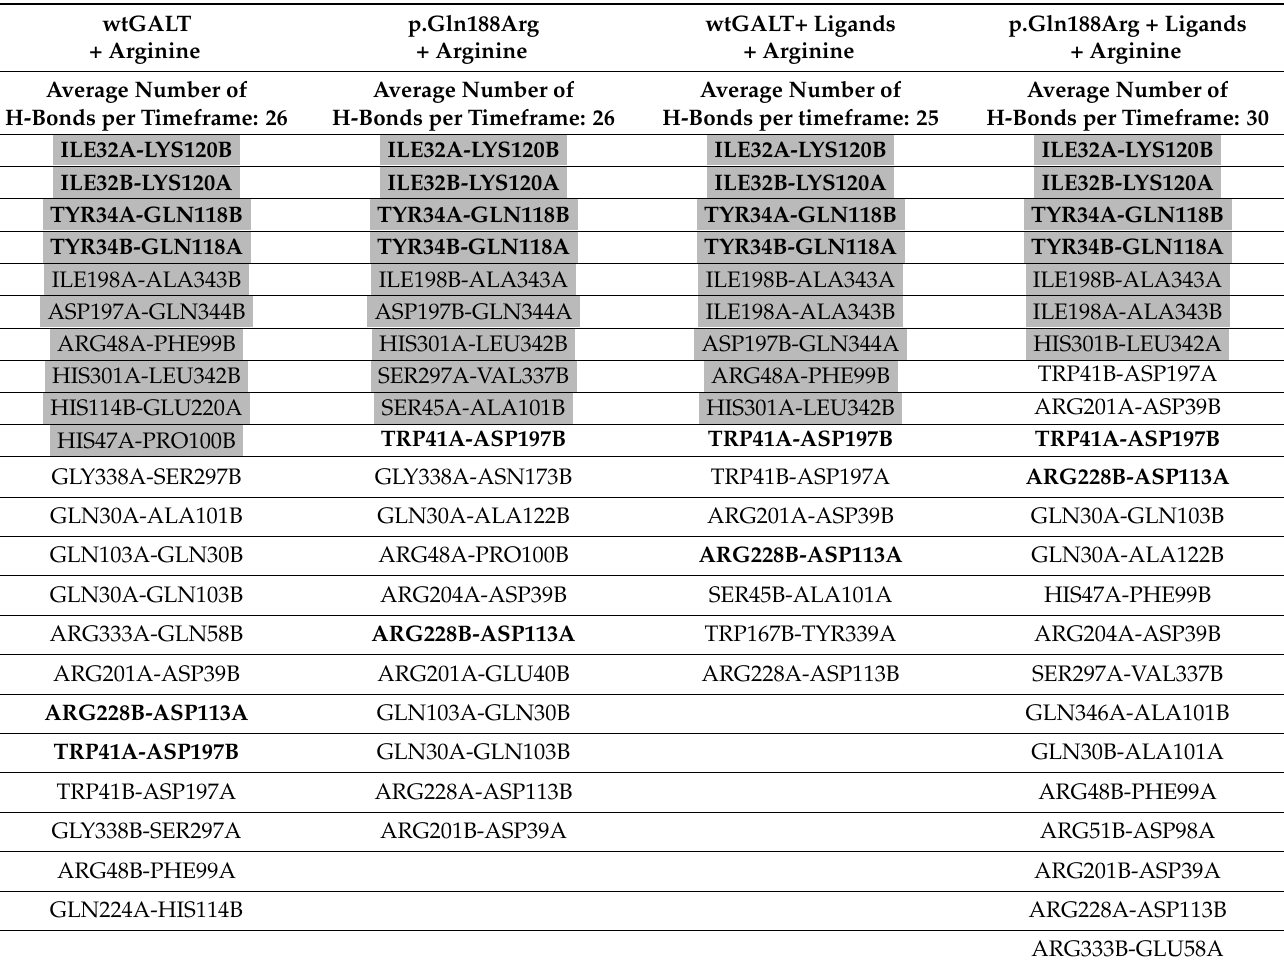
Table 4. Couples of residues involved in stable intersubunit H-bonds in simulations with arginine in the central cavity. Dark gray background: intersubunit interactions identified in the initial models and conserved throughout the simulations; bold: stable interactions present in all systems. Couples of residues are considered to have a stable H-bond interaction when the sum of % of existence of the H-bonds between the two residues is ≥